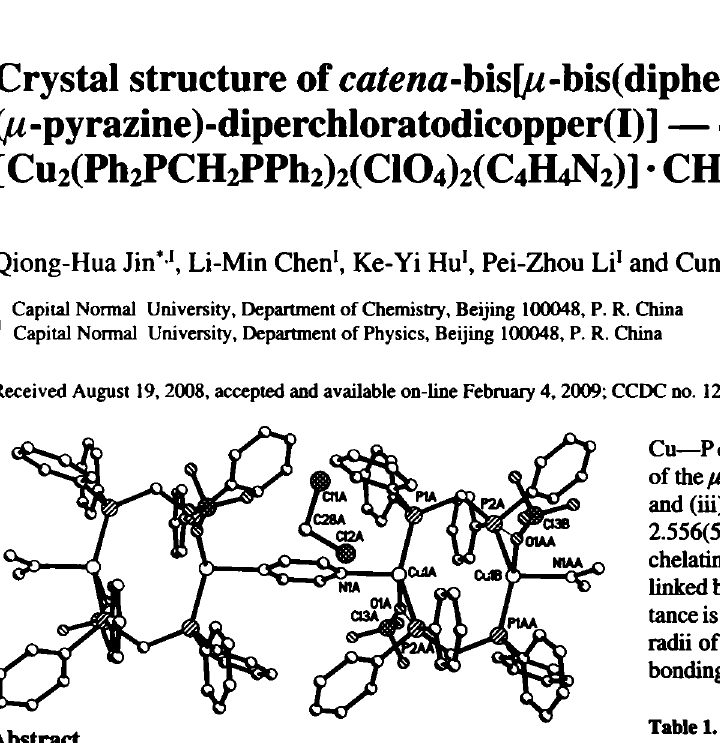
Table 2. Atomic coordinates and displacement parameters (in A